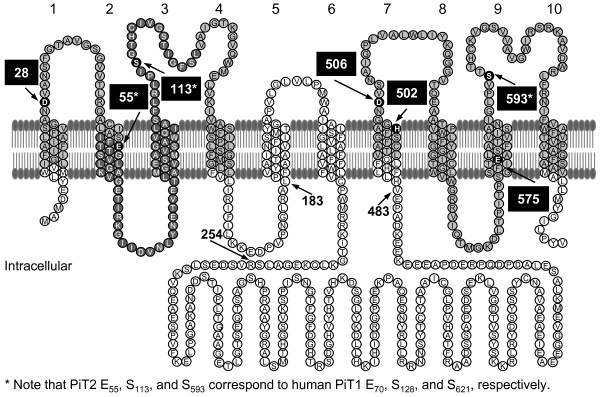
Putative topological model of human PiT2 and mutants. Putative membrane topology model of human PiT2 on which the mutant proteins investigated in the present paper are based; the model was originally proposed by O'Hara and coworkers [8,20]. The numbers of the TMs are indicated above the model. Other membrane topology models have been proposed for PiT1 [22,23] and PiT2 [24], which suggested diverging topology for the two paralogs; the alternative PiT2 model is shown in Figure 2. The amino acids previously identified in human PiT2 as being critical for Pi transport function are highlighted with black filling and pointed out with arrows; D28, E55, S113, D506, E575, and S593[18,27,28]. In human PiT1, the amino acids S128 (PiT2 S113) and S621 (PiT2 S593) have previously been identified as being critical for PiT1 Pi transport function [29]. In the present study, human PiT2 H502 (situated in the PiT family signature sequence) and human PiT1 E70 (equivalent in position to human PiT2 E55) are also identified as critical for Pi transport function (see Figure 3). The grey-filled sequences (L11-L161 and V492-V640), represent the N- and C-terminal, respectively, ProDom domains (PD001131) published in 2004 defining the PiT family members [27]. The dark grey-filed sequence (I53-L127) represents the most recent ProDom domain defining the PiT family members http://prodom.prabi.fr/.